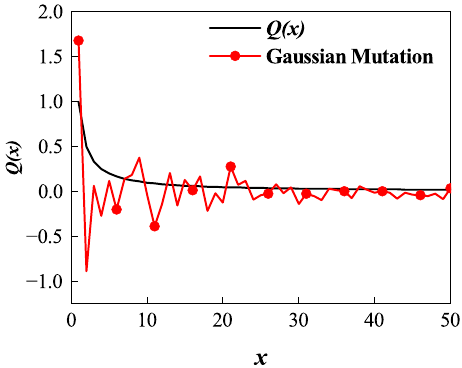
Figure 8. Schematic of Gaussian mutation.